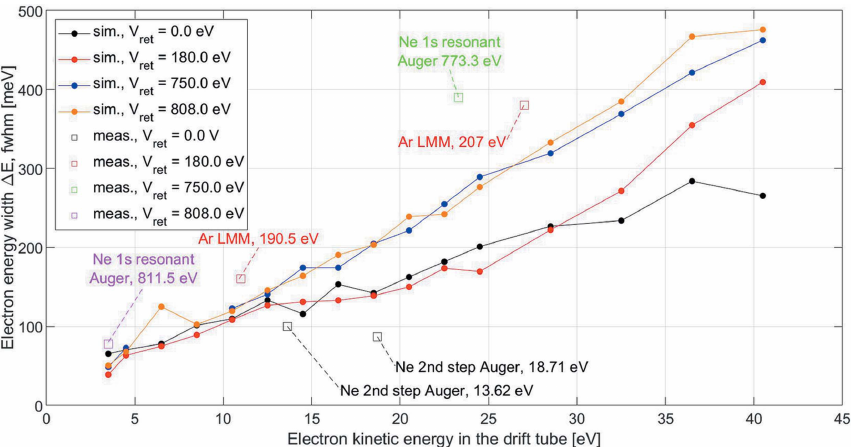
Figure 3 Simulated and measured electron energy widths for different electron energies and different retardation V ret . Isolated squares and linked circles are for measurements and simulations,